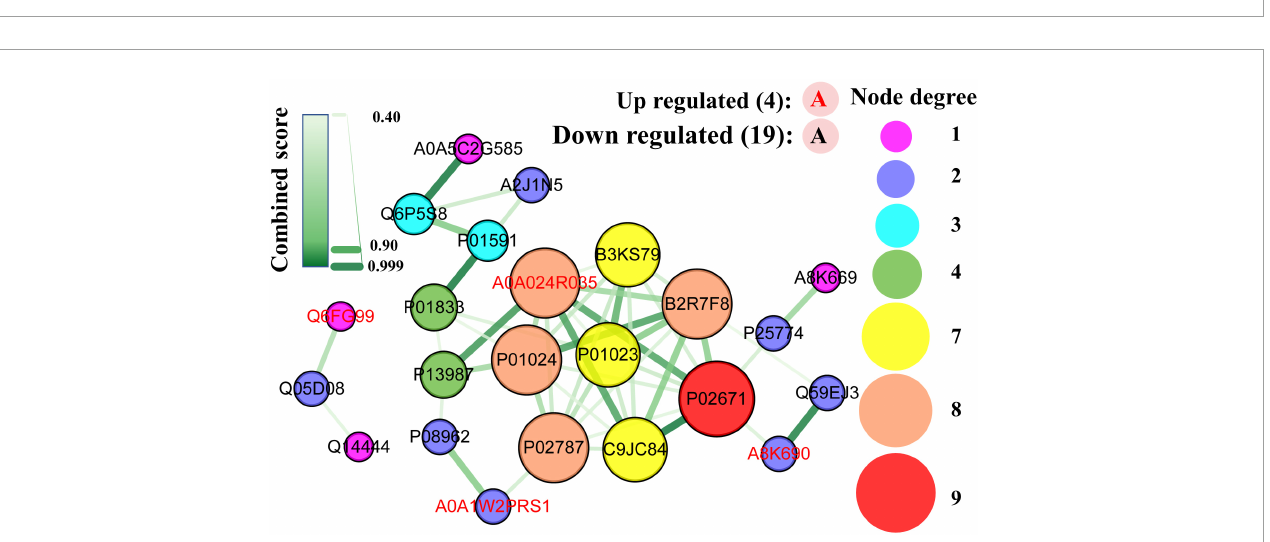
FIGURE10 Protein-protein interaction network map of differentially expressed caseins from Korean and Han ethnic groups in China. Each node represents a protein, and each edge represents the direct interaction between proteins.